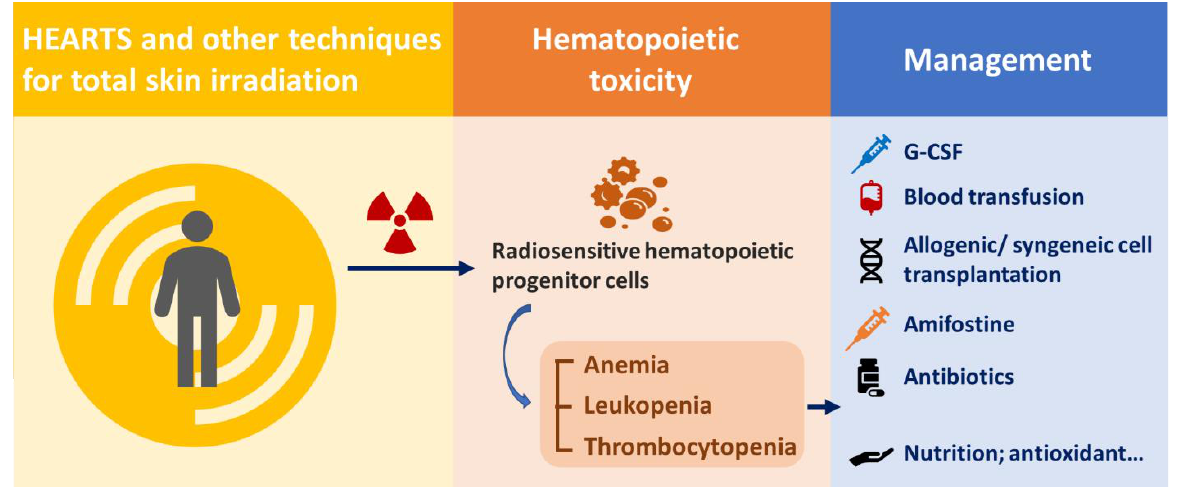
Figure 3. Management of hematopoietic syndrome caused by HEARTS and other techniques for total skin